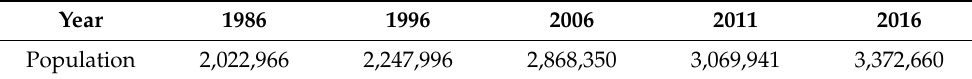
Table 2. Population of Mashhad city (National Statistical Center of Iran,